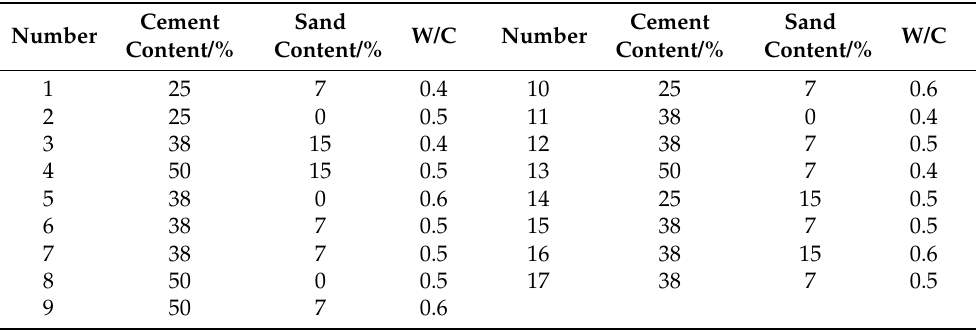
Table 6. Experimental